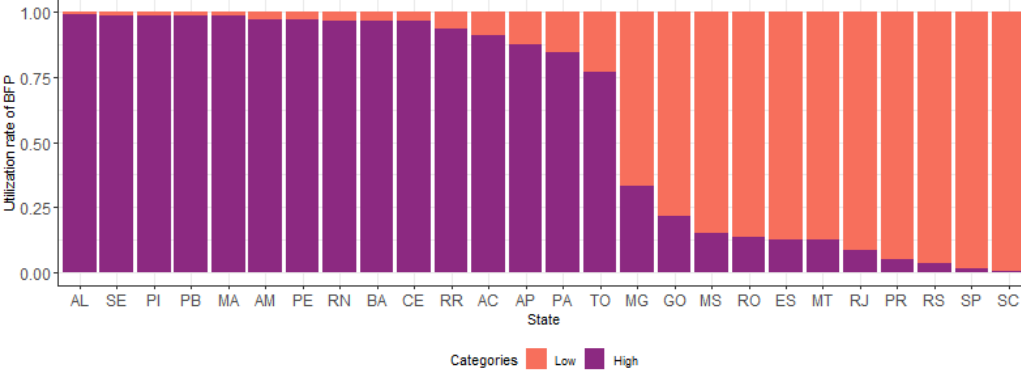
Figure 5. Utilization rate of BFP with two classes by state. Source: prepared by the